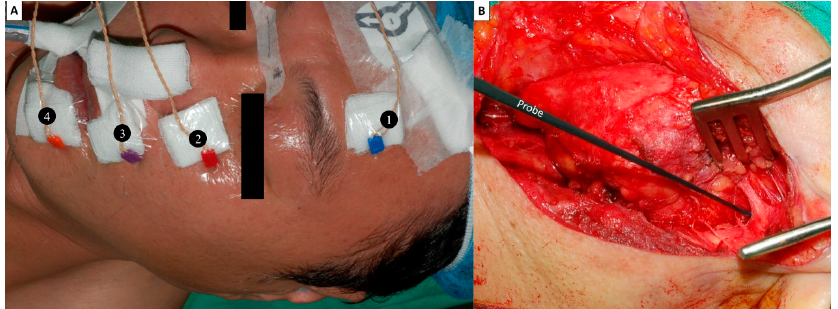
Figure 1. Facial nerve (FN) monitoring setup. ( A ) Recording electrodes: Four paired needle electrodes are inserted deeply into the muscles over the ❶ lower forehead, ❷ infraorbital area, ❸ superolateral upper lip and ❹ inferolateral lower lip on the ipsilateral side to monitor the activity of four regional muscle groups innervated by the temporal, zygomatic, buccal and marginal man- dibular branches of the FN. ( B ) A ball-tip (1.0 mm) monopolar stimulating probe was used. The Localization (L, 5 mA) stimulus for the FN trunk was evaluated during parotid gland dissection and facilitated identification of the FN trunk.